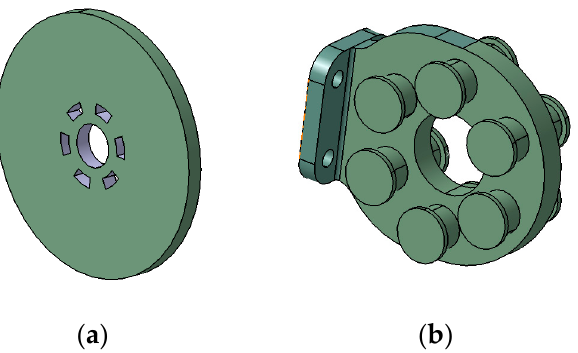
Figure 2. Structural diagram of the electromagnetic damper: ( a ) Rotor disk; ( b ) Stator disk.